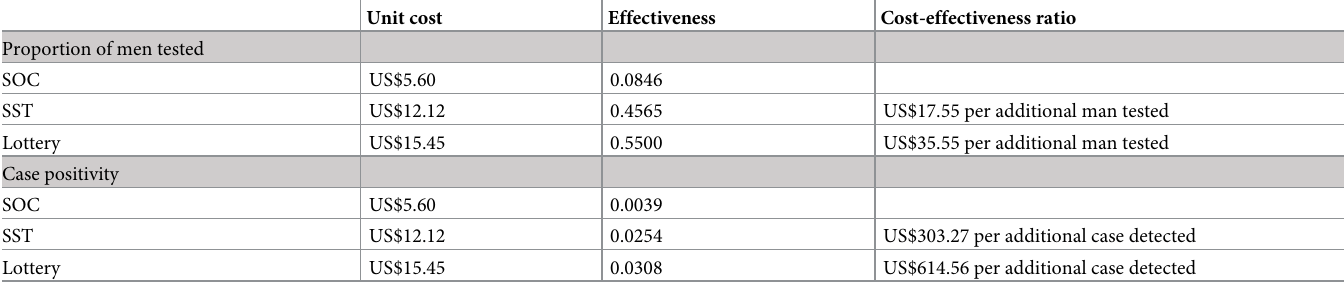
Table 3. Incremental cost per additional person tested and per additional case detected of syphilis testing strategies among MSM in